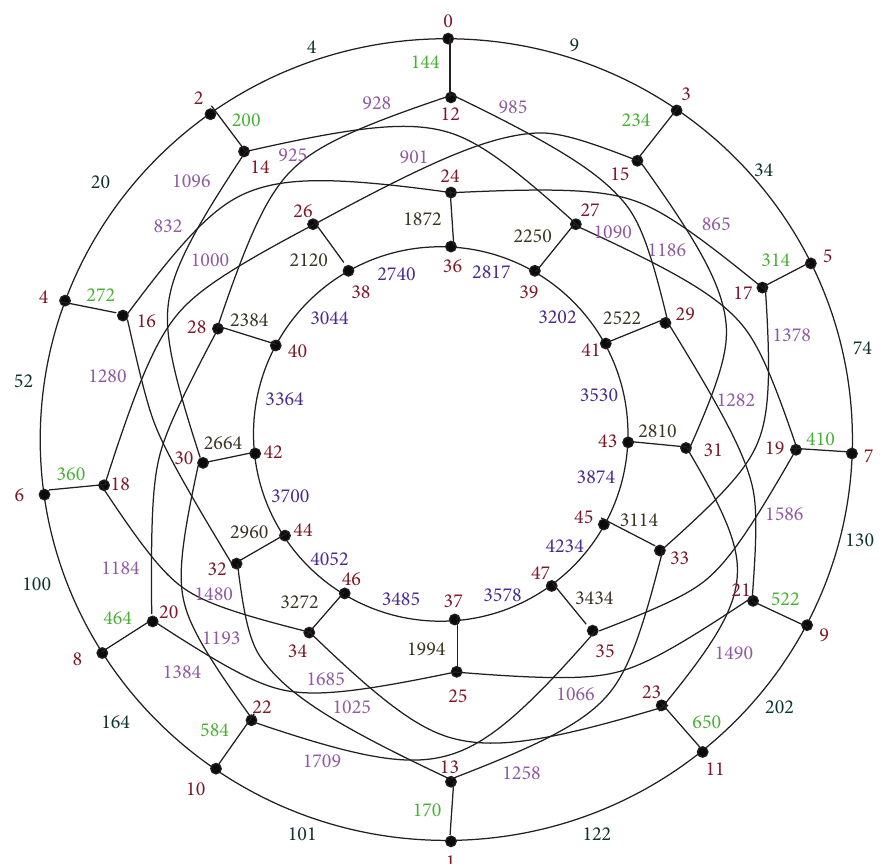
Figure 5: Square sum labeling of DP [ 12 , 2 ]